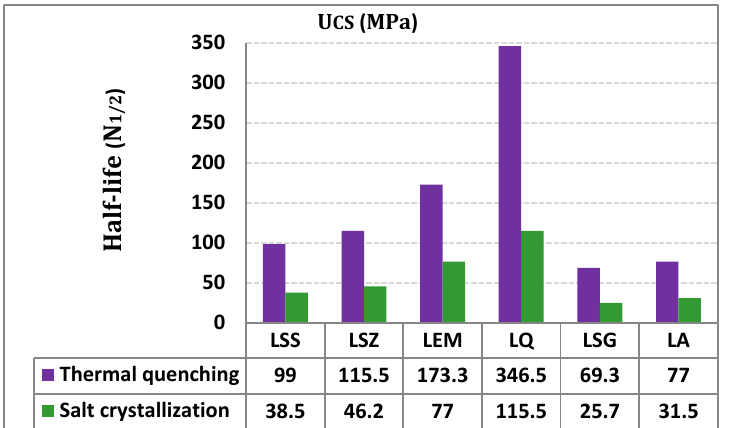
Figure 10. Half-life values of uniaxial compression strength of limestones under the thermal and salt weathering.